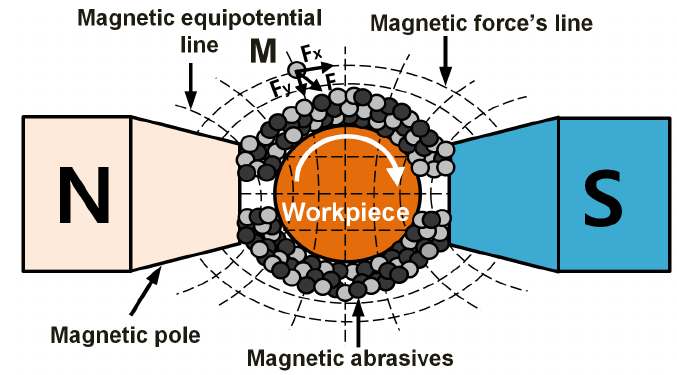
Figure 1. Schematic diagram of external micro-machining process using magnetic field.